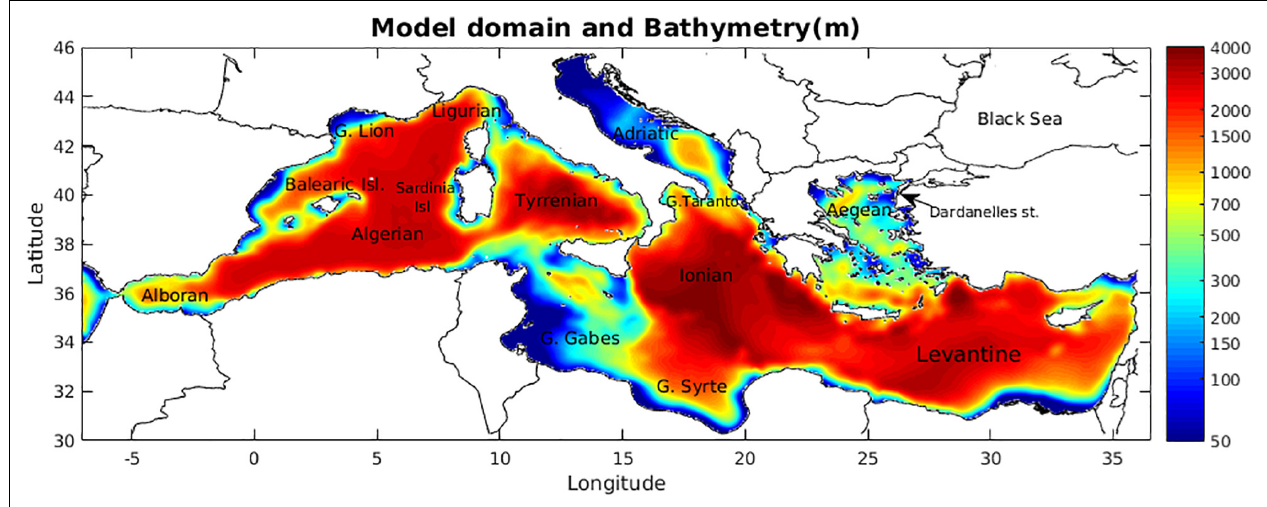
FIGURE 1 | Mediterranean model domain and bathymetry. The color bar is on a logarithmic scale.